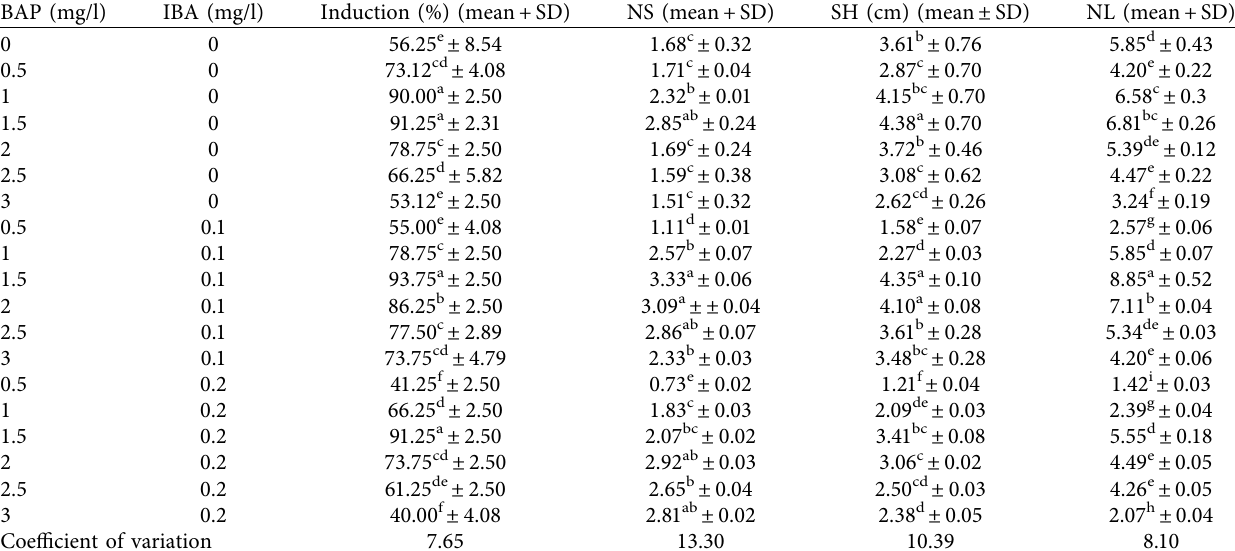
Table 2: Effect of BAP and BAP ∗ IBA on in vitro shoot induction of korarima. BAP (mg/l) IBA